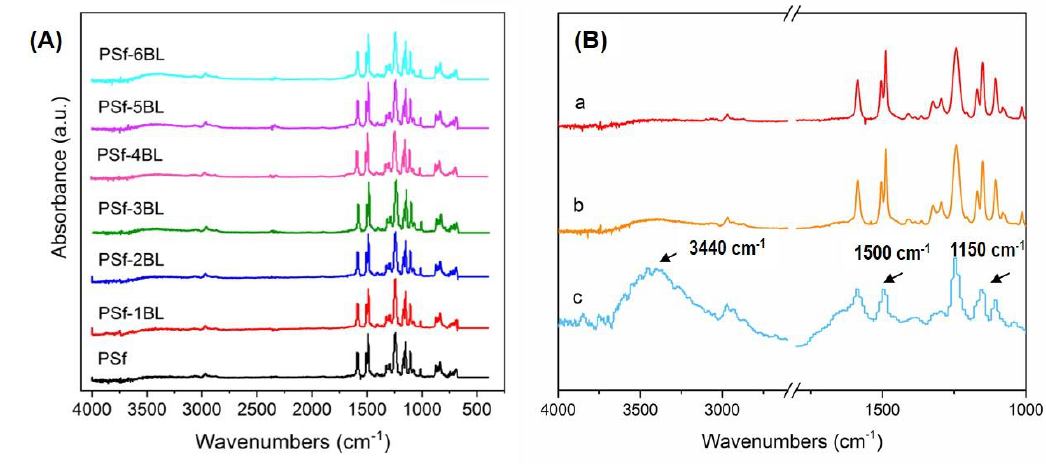
Figure 2. ATR-FTIR spectra of ( A ) PSf membranes with different bilayer numbers, and ( B ) PSf ( a ) and PSf-5BL ( b ) membranes, and their differential spectrum ( c ).